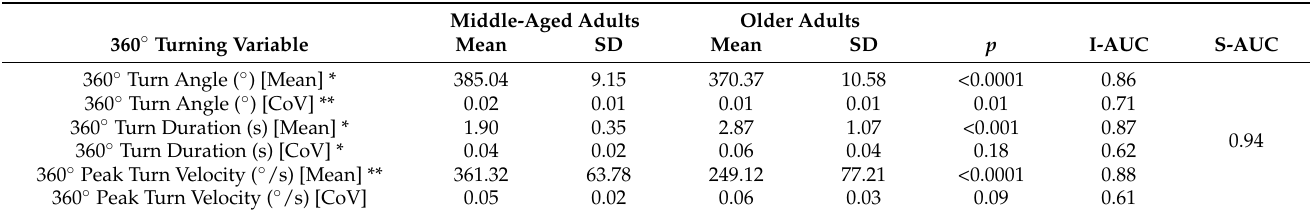
Table 5. Means, standard deviations, significance ( p ), independent AUC (I-AUC), and stepwise AUC (S-AUC) measures for 360 ◦ turning variables. Variable(s) with a single (*) were included in the stepwise regression, those with a (**) were maintained in the regression model for further AUC assessment and discriminatory ability.